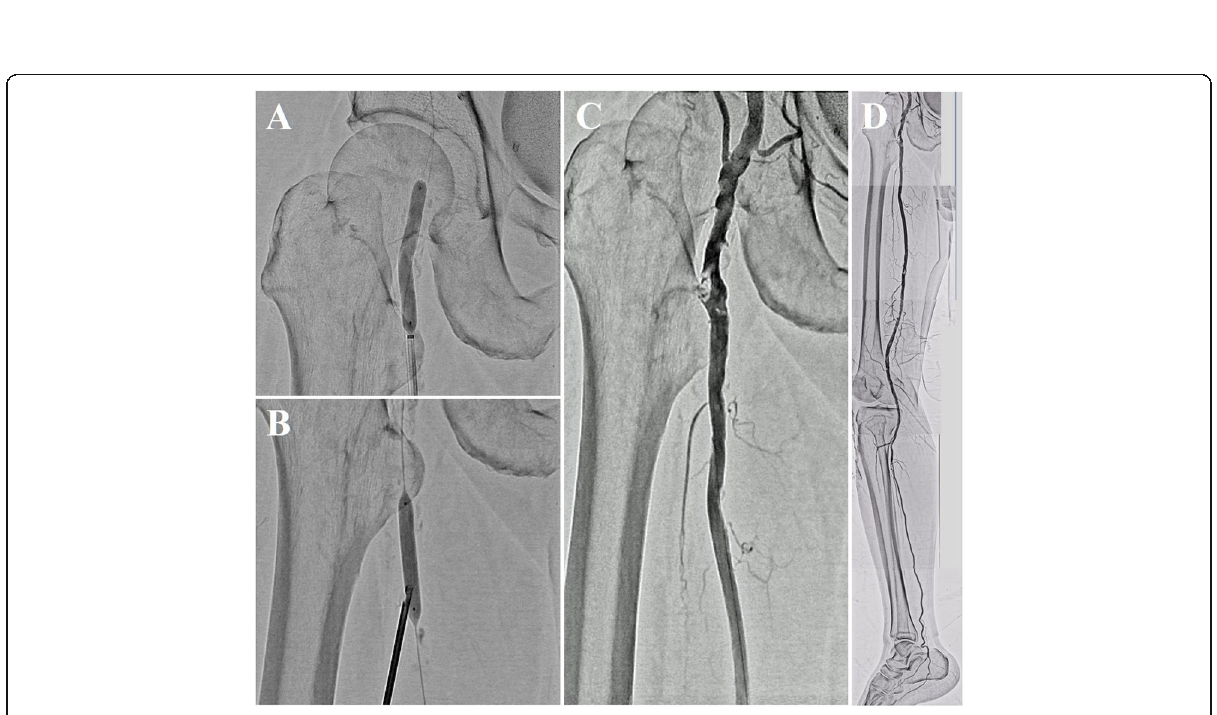
Fig. 3 A Inflation of a 6-mm drug-coated balloon catheter in the common femoral artery (CFA). B Hemostasis of the puncture site of the superficial femoral artery with vascular suture assisted by balloon inflation inside the vessel. Final angiography image demonstrating a reduced filling defect of contrast medium in the CFA ( C ) and favorable blood flow as far as below the ankle ( D